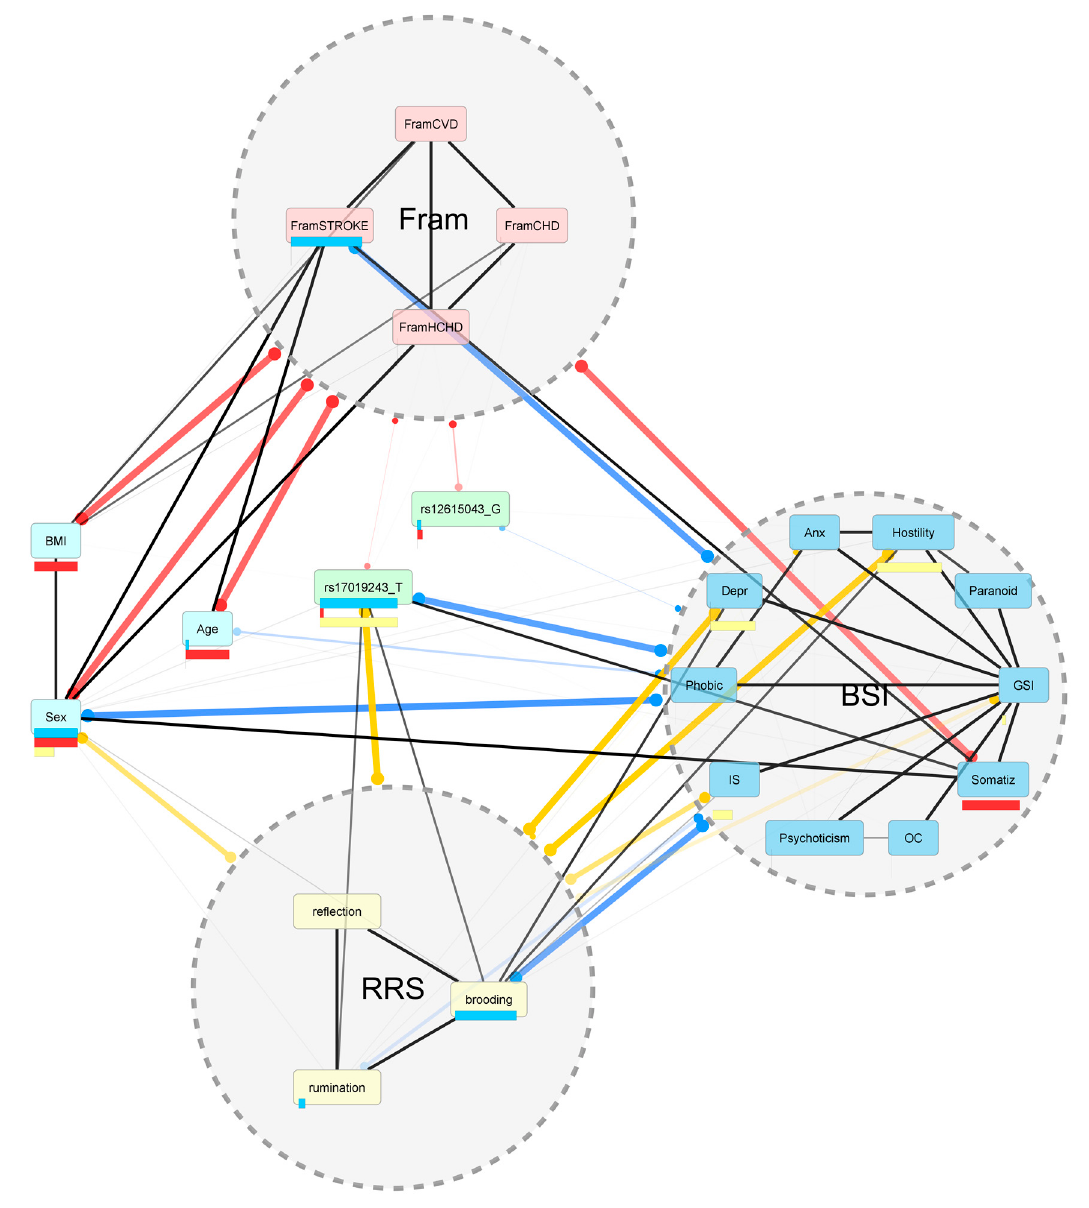
Figure 2. The resulting network model from the Bayesian Multilevel Analysis. The edges (all lines) represent a probabilistic relationship between the variables, namely single variables and categories of variables. Single variables include the 18 phenotypes, sex, age, and the two SNPs. Categories of variables include Framingham, RRS, and BSI. The thickness of the edges is proportional with the posterior probability, signifying a more probable real-life connection between the variables (numerical posterior probability values are detailed in Supplementary Table S3). The black edges connect single variables with each other, and the colored edges connect single variables with the categories, where the color encoding is as follows: red—Framingham; yellow—RRS; blue—BSI. The length of the horizontal bars below the nodes represents the posterior probability values with respect to the categories. The results suggest a real-life relationship between rs17019243 and RRS, and BSI single variables and categories as well. However, rs12615043 has no real-life relationship with any of them. RRS—Ruminative Response Scale; BSI—Brief Symptom Inventory; BMI—body mass index;